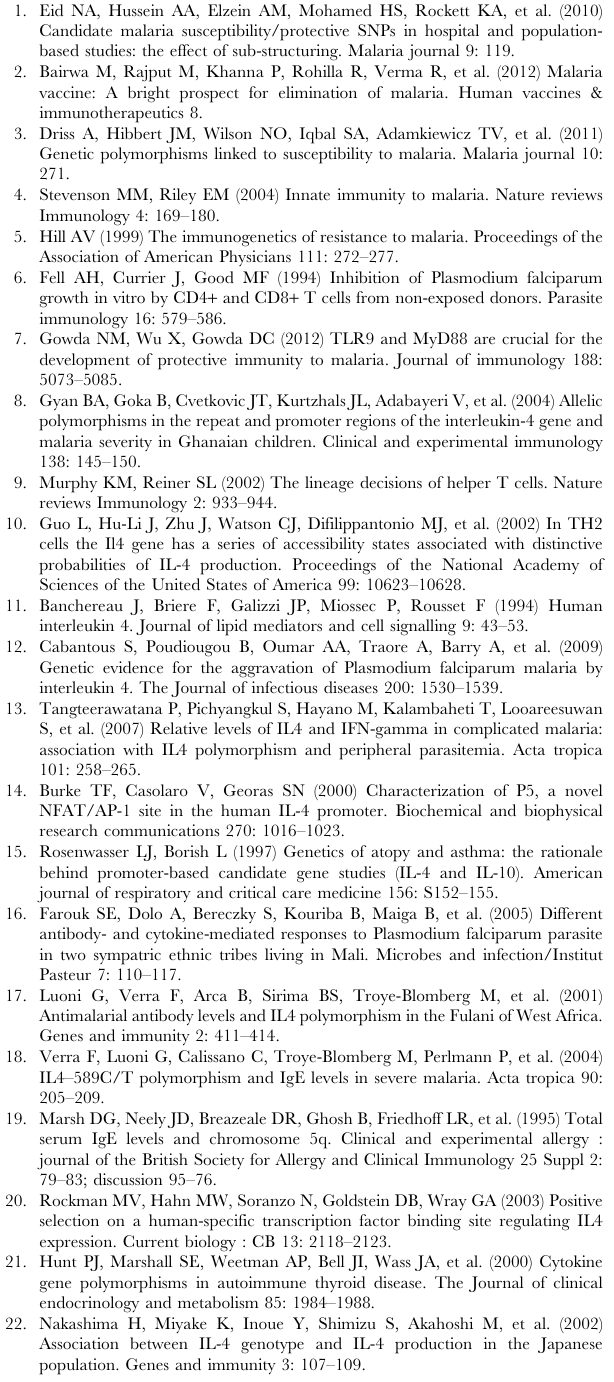
Table S3 Comparison of IL4 intron-3 VNTR polymorphism R2/R3 between patient and asymptomatic group, stratified by sex